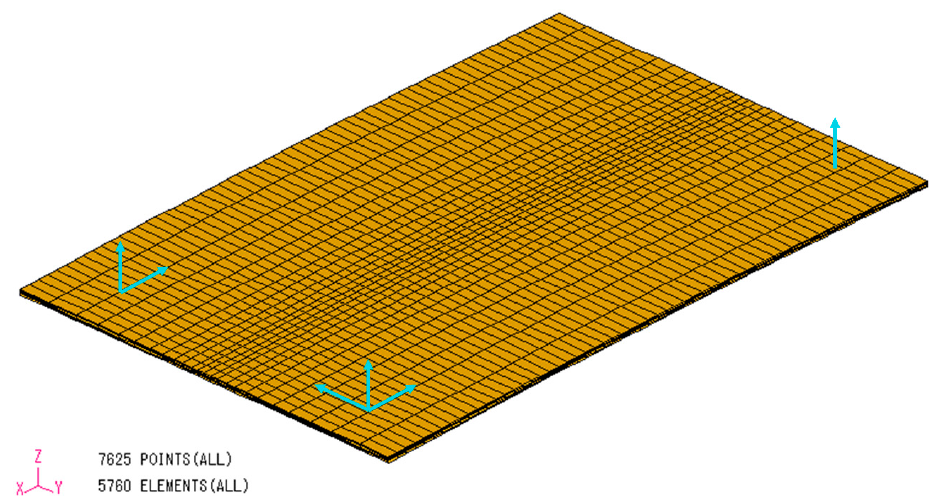
Figure 7. Finite element model of the plate by Tungsten Inert Gas (TIG) welding.